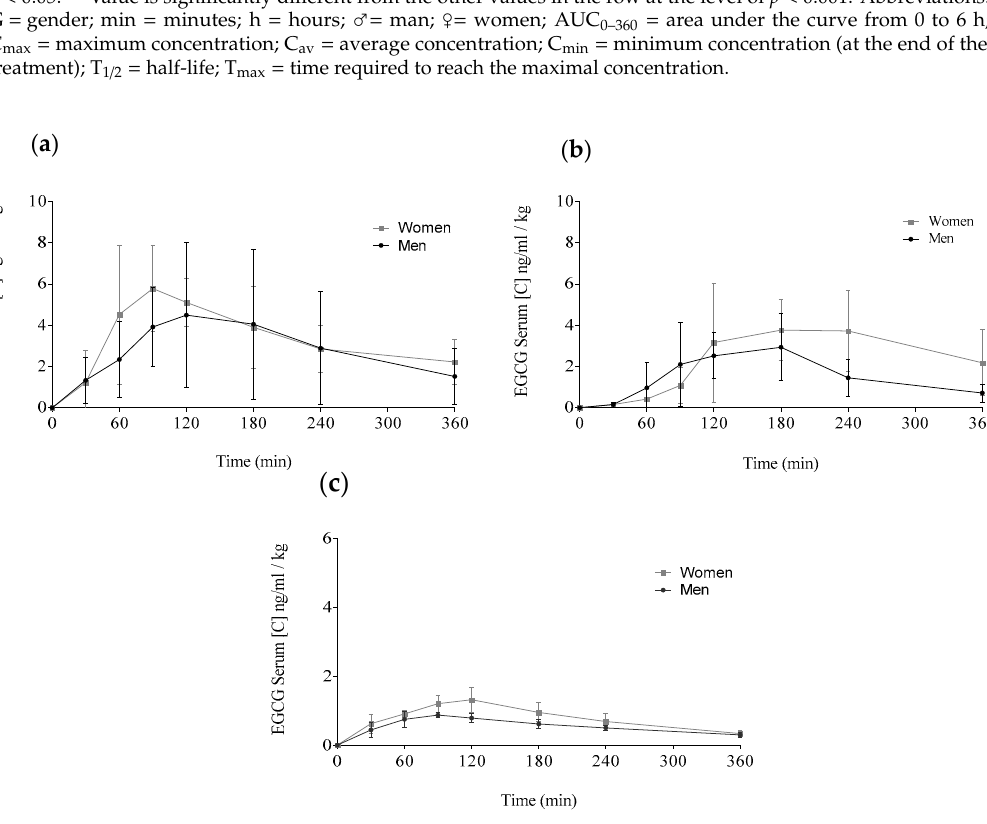
Figure A1. Comparison of the EGCG means distributed by delivery method and gender: Concentrations for women are showed by grey lines and, for men, by black lines. ( a ) Teavigo ® alone, ( b ) Teavigo ® plus breakfast, and ( c ) FontUp ® . Each value was obtained by HPLC-MS analysis.